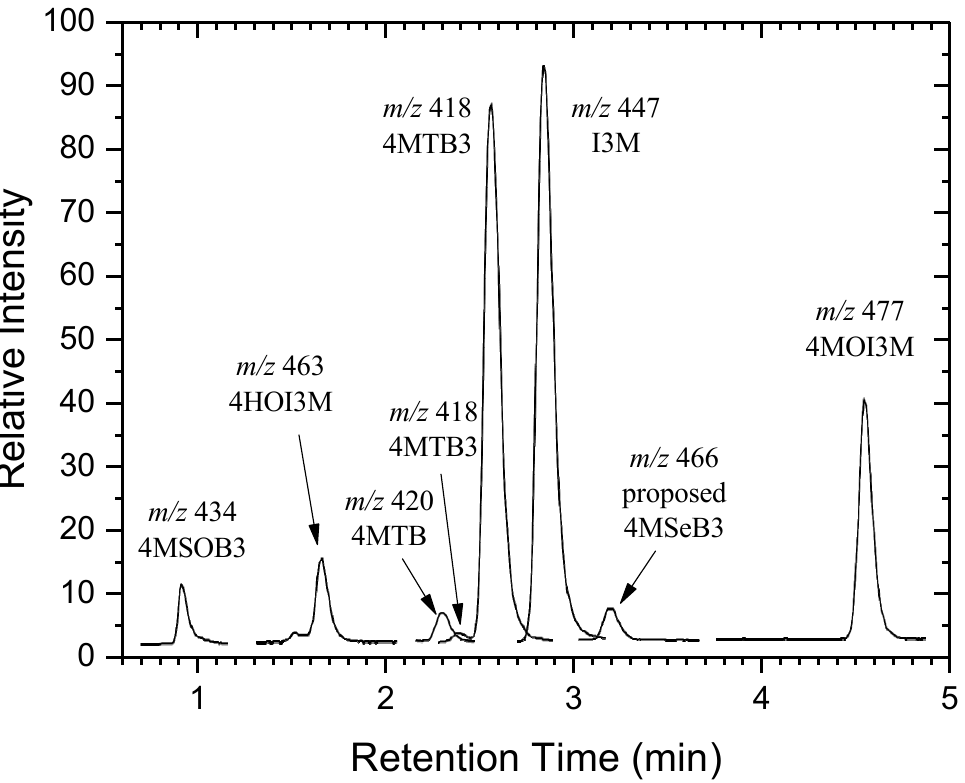
Figure 2. Reconstructed Liquid Chromatography-Mass Spectrometry (LC-MS) ion chromatogram of the pseudomolecular ions [M-H] − of naturally occurring glucosinolates and putative seleno-glucosinolates identified in an ethanol extract of Raphanus sativus sprouts fertilised with selenium.